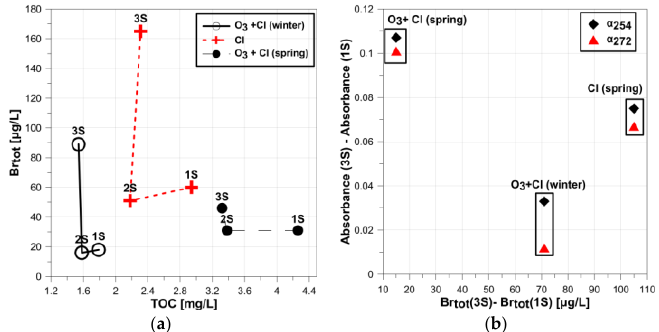
Figure 6. Parameters of water in the water treatment line (TOC, absorbance and total bromine concentration in raw water (1S), water after filtration (2S) and after disinfection (3S)). ( a ) Total bromine concentration versus TOC concentration. ( b ) Differences in absorbance versus differences in total bromine concentration.